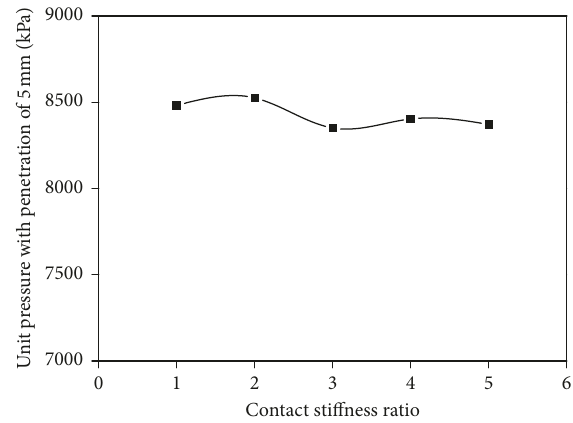
Figure 5: Variation in contact stiffness